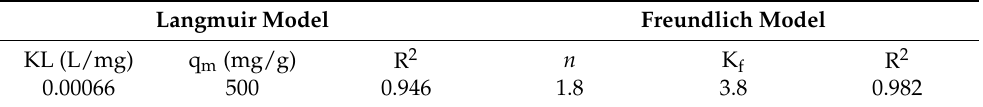
Table 2. Parameters of Langmuir and Freundlich isotherms for COD adsorption onto sheep dung